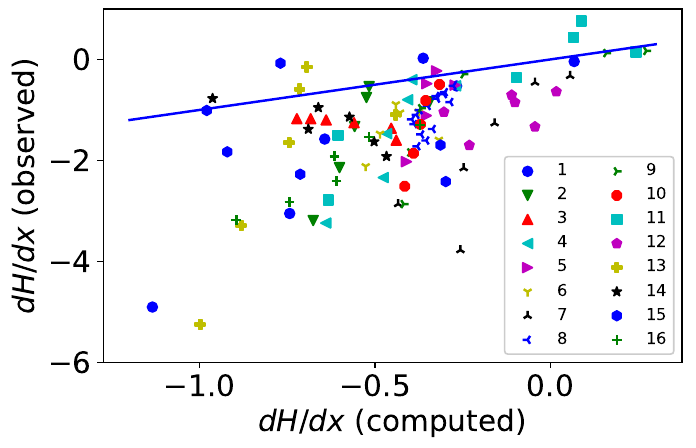
Figure 12. Observed change of the breach height dH / dx in Experiments 1-16 versus the computed dH / dx using Equations (1) and (3)–(5). The solid line represents perfect